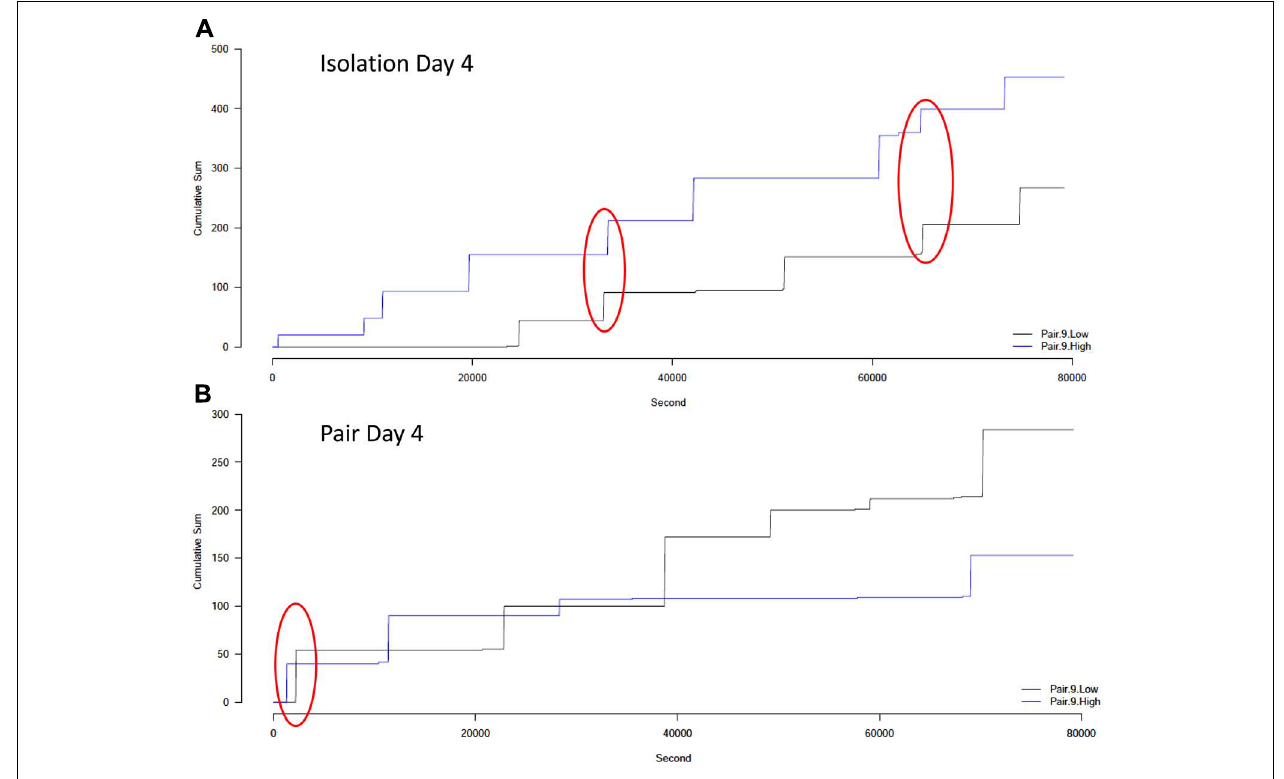
FIGURE 6 | Cumulative number of licks of ethanol over 22 h for an example pair. (A) The drinking patterns for subjects in a pair on the last day of isolation. (B) The drinking patterns for subjects in the same pair on the last day of pair housing.The high drinker is shown in blue and the low drinker is